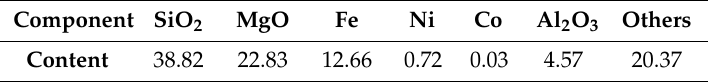
Table 2. The composition of the CaF 2 (wt. %).